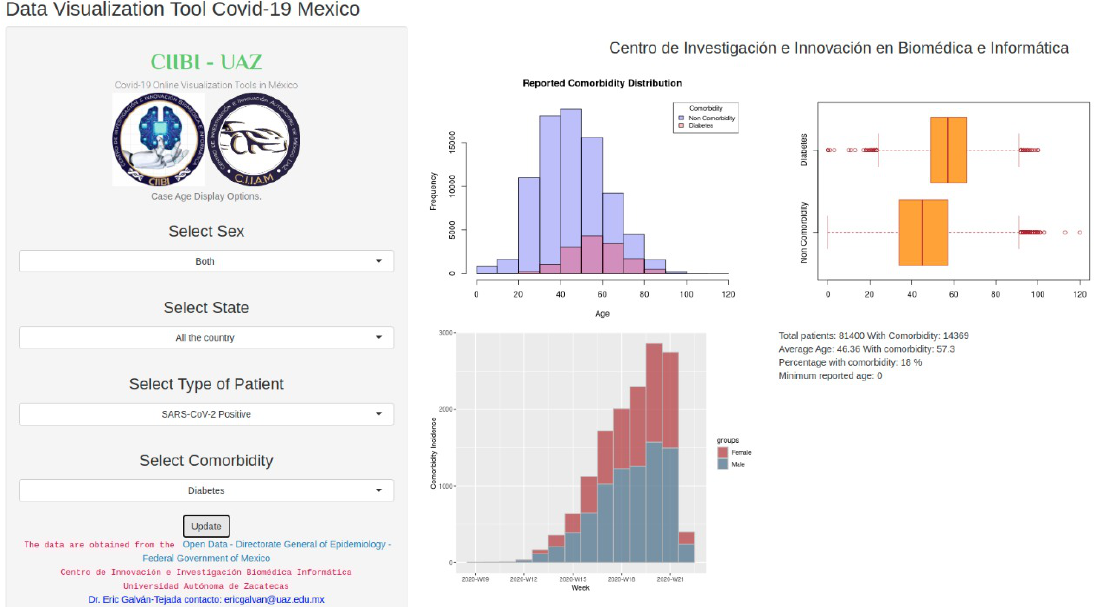
Figure 3. Layer of the web interface that allows to analyze the behavior of COVID-19 based on comorbidity